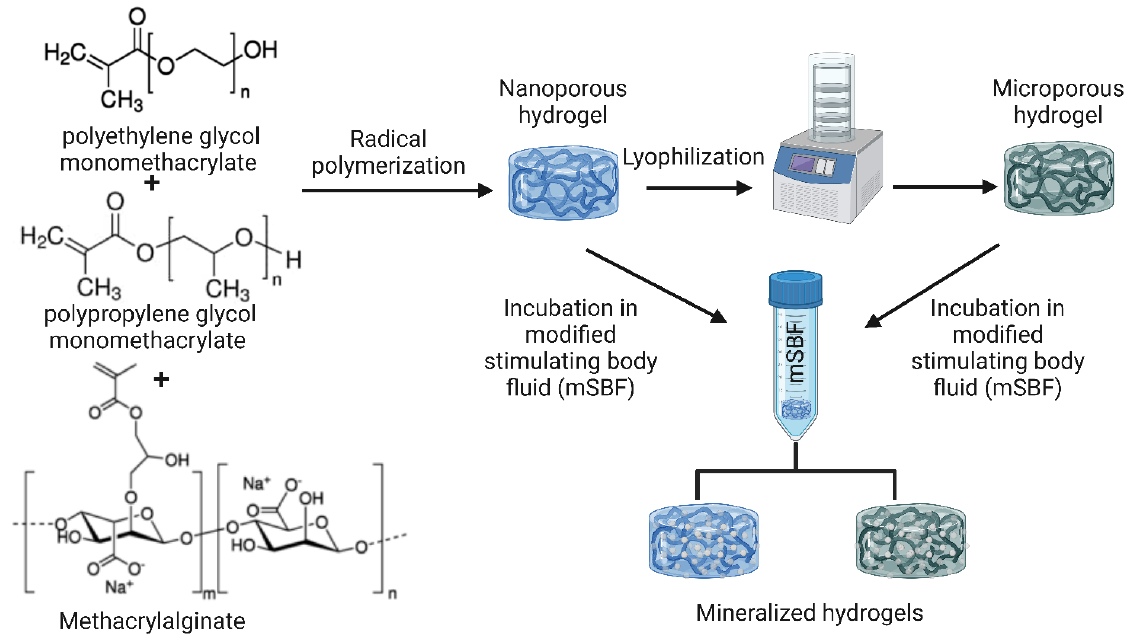
Figure 6. PPGmM and PEGmM were chemically crosslinked to form hydrogels using MA as a crosslinking agent. The resulting hydrogels (nanoporous hydrogels) and hydrogels freeze-dried to microscopic pores (microporous hydrogels) were incubated in mSBF to induce biomineralization [129]. The image was created using Biorender.